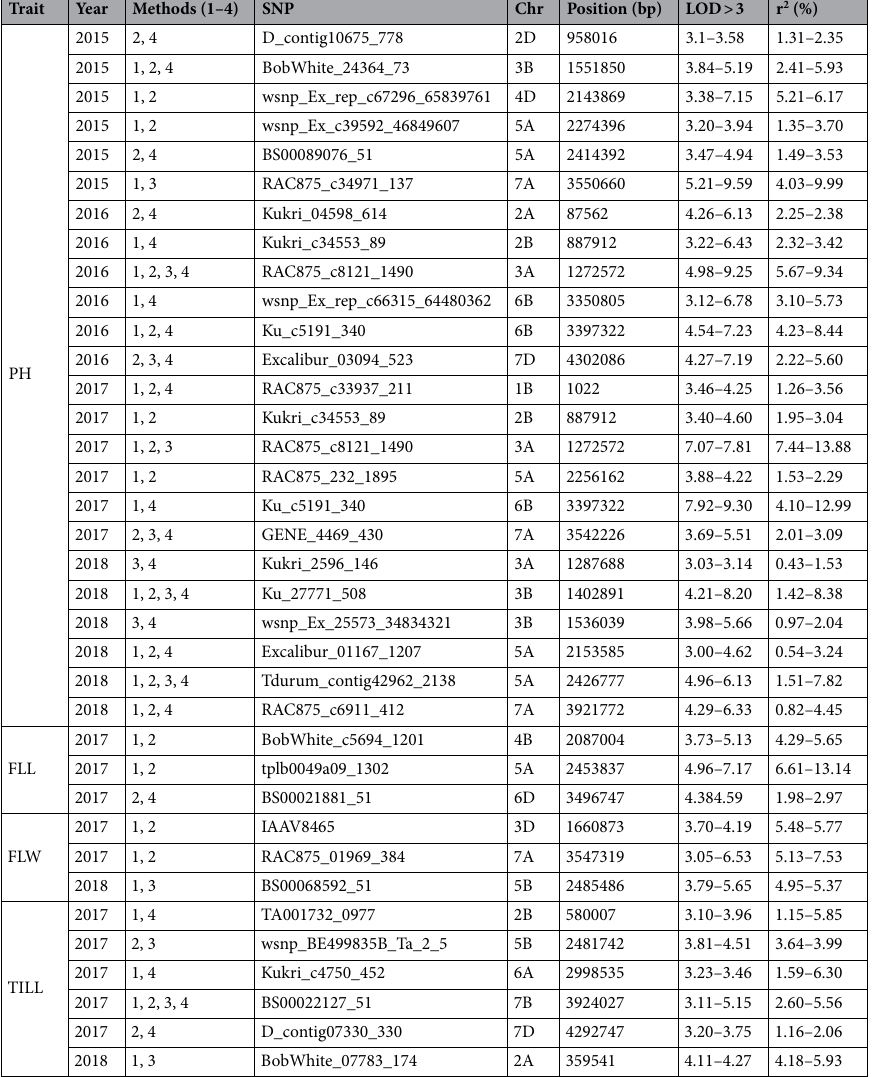
Table 1. Common SNPs detected through different ML-GWAS methods associated with plant architectural traits. Methods (1–4): corresponding four multi-locus GWAS methods i.e. mrMLM, FASTmrMLM, FASTmrEMMA, and pLARmEB, respectively. r 2 (%) represents proportion of total phenotypic variation explained by each SNP. PH (plant height); FLL (flag leaf length); FLW (flag leaf width); TILL (number of tillers per plant).